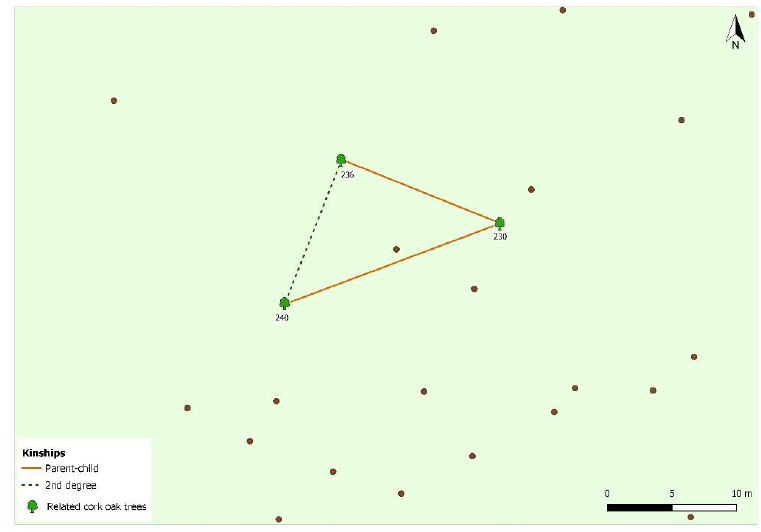
Figure 5. Spatial distribution of the reconstructed pedigree for a cork oak family comprising three individuals. The parent – child and second-degree relationships are illustrated.